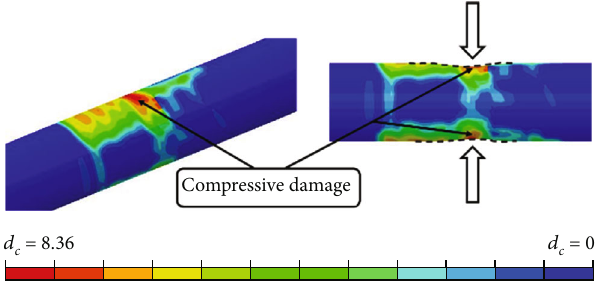
Figure 6: Compressive damage factor cloud image.